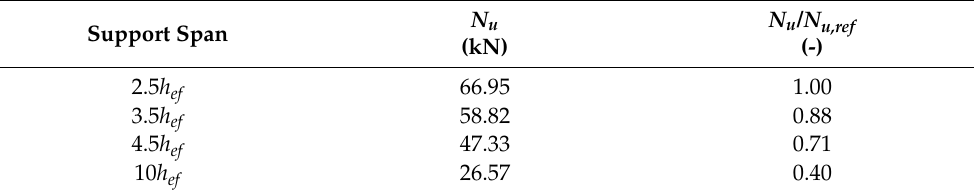
Figure 4. Breakout patterns at the ultimate load for: ( a ) support span of 2.5 h ef ; and ( b ) support span 4.5 h ef (symmetry was utilized). Table 2. The influence of support span .